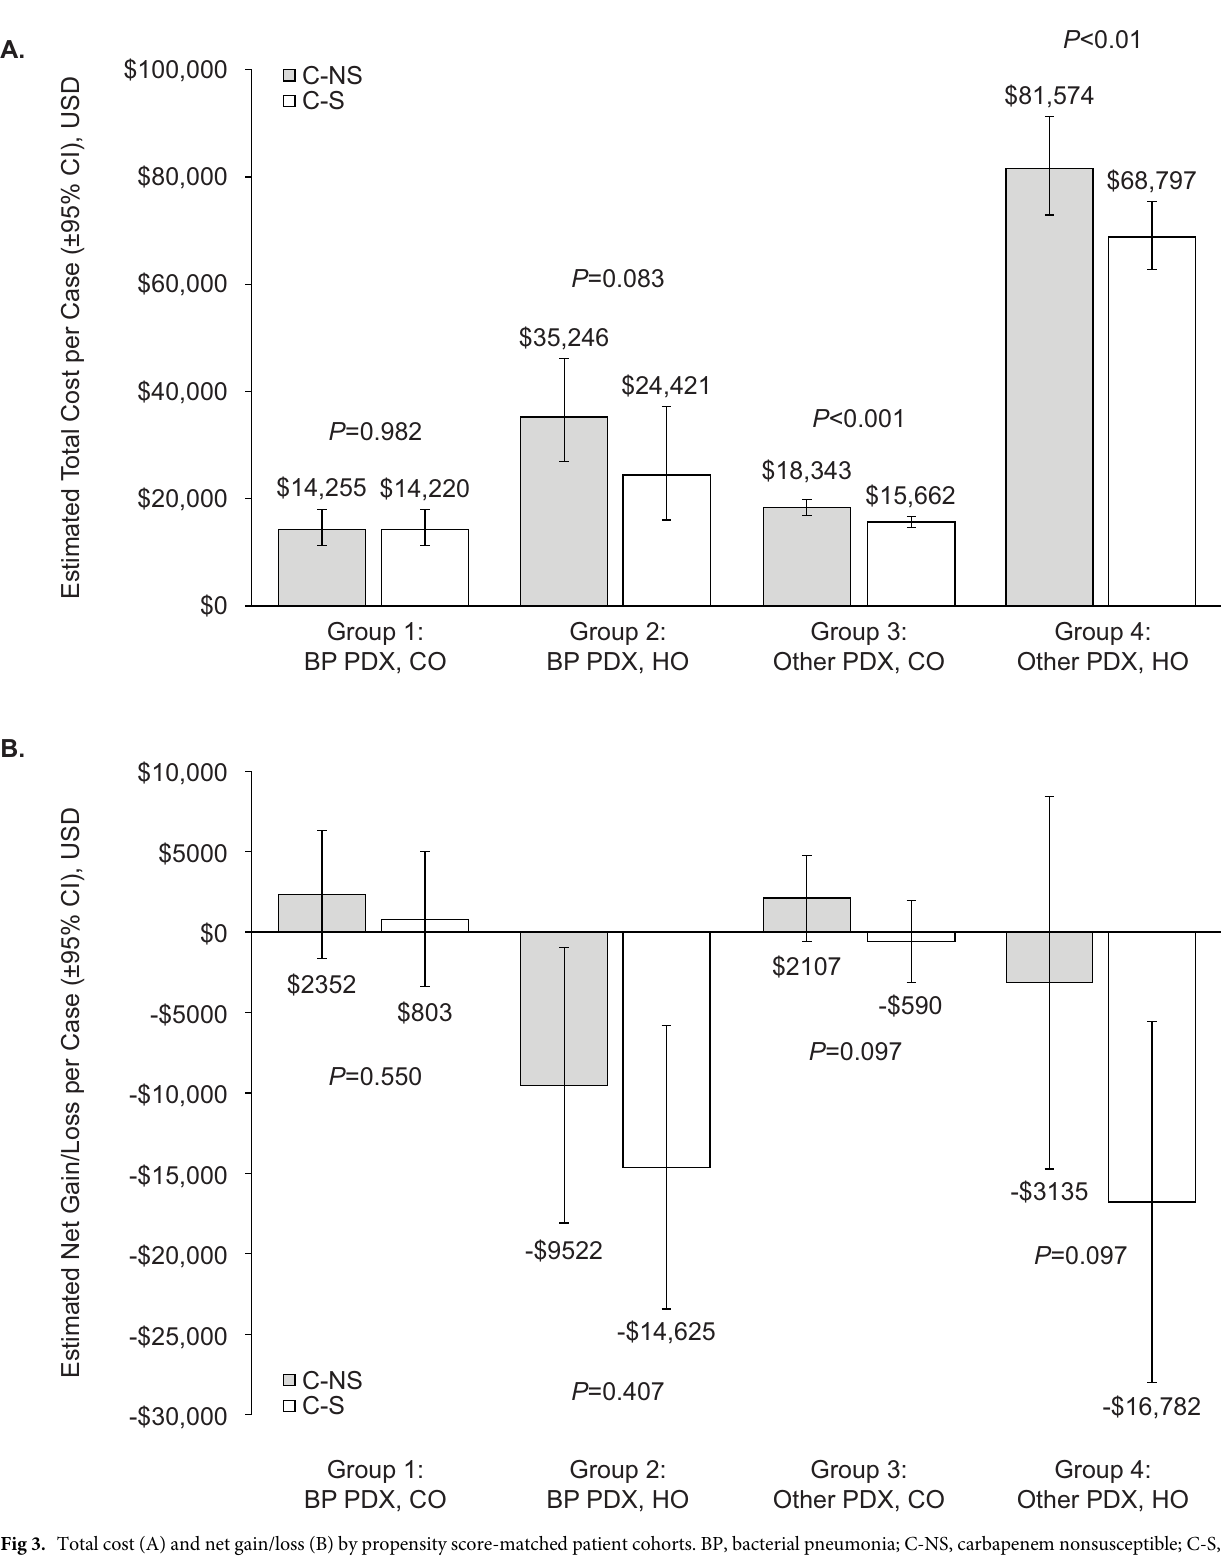
Fig 3. Total cost (A) and net gain/loss (B) by propensity score-matched patient cohorts. BP, bacterial pneumonia; C-NS, carbapenem nonsusceptible; C-S, carbapenem susceptible; CI, confidence interval; CO, community-onset; HO, hospital-onset; PDX, principal diagnosis; USD, United States dollars.